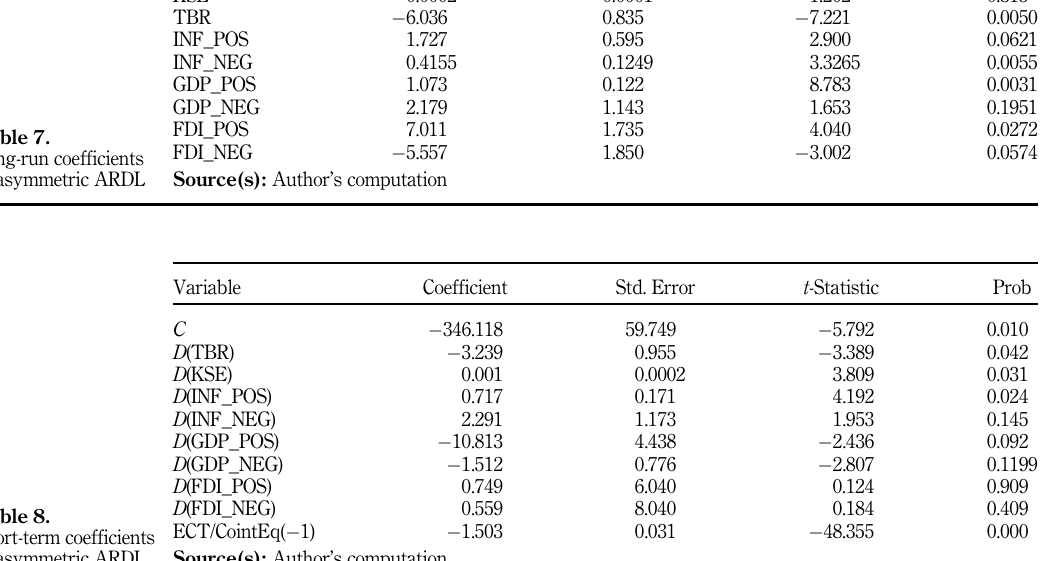
Table 8. Short-term coefficients of asymmetric